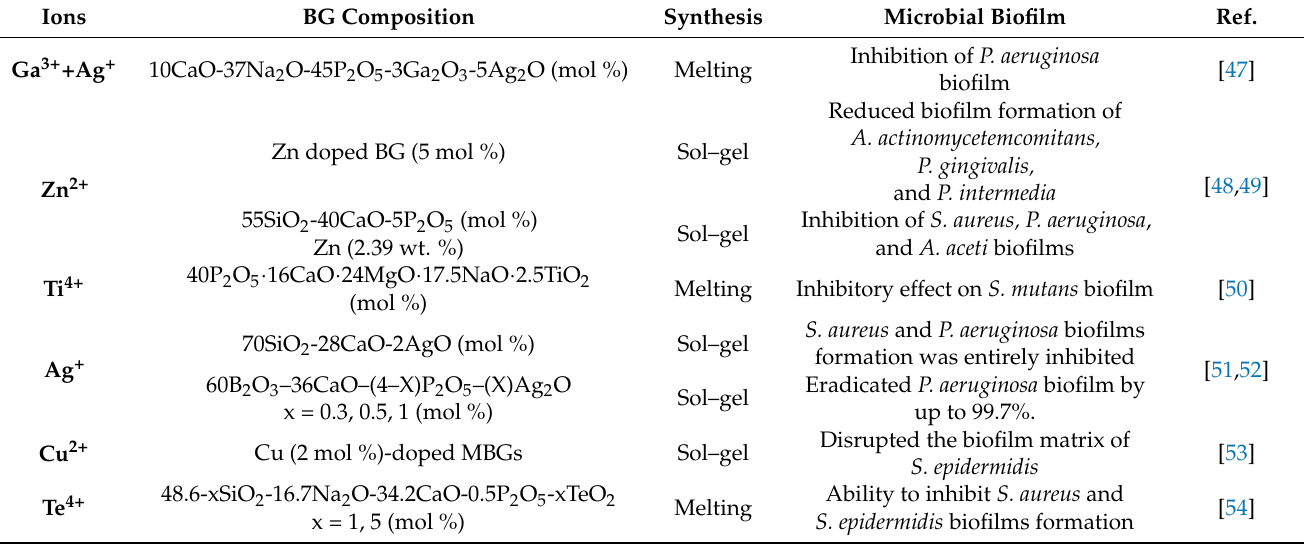
Table 1. The inhibitory ability of bacterial biofilm of some metal ions. Ions BG Composition